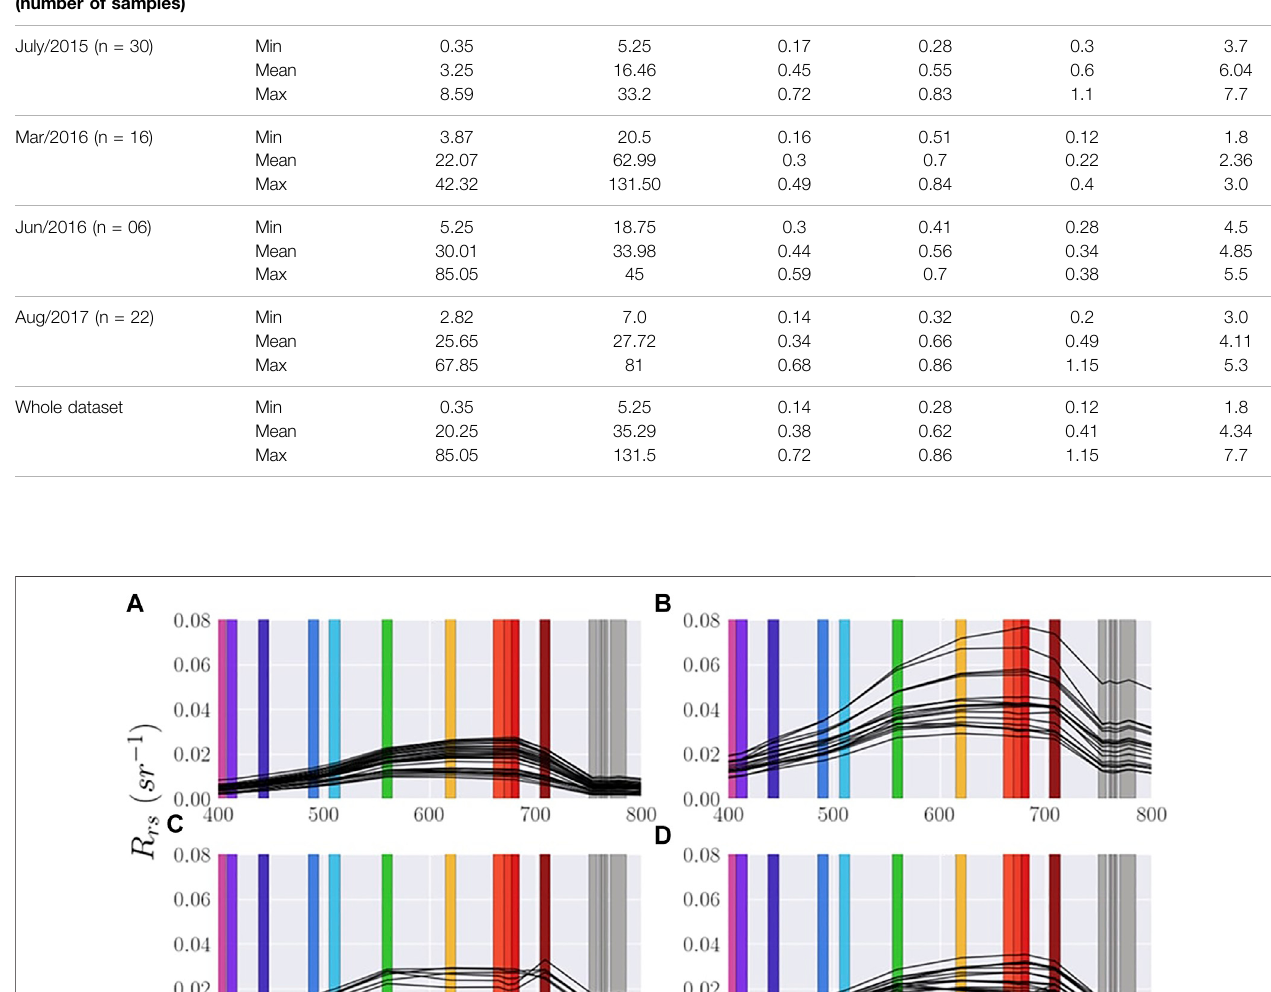
TABLE 1 | Minimum (min), mean, and maximum (max) values for Chl-a, TSS, TSO/TSS ratio, TSI/TSS ratio, Secchi disk depth, and water depth for each campaign. Campaign (number of samples)